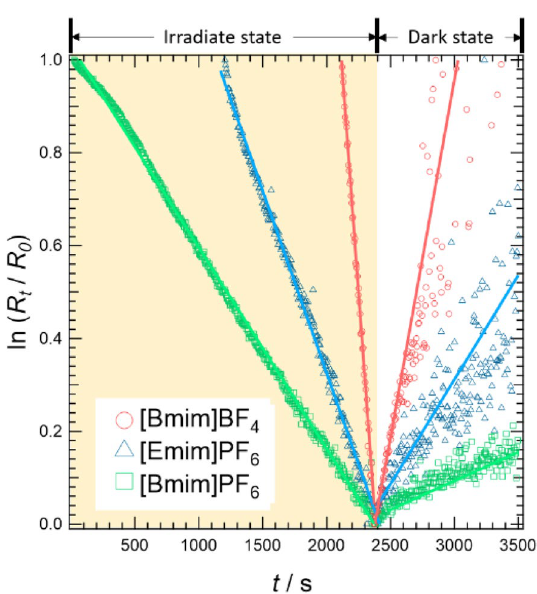
Figure 6. The time variation of the reflection spectrum intensity ln( R t / R 0 ) at λ = 575 nm is shown. The bottom axis indicates the time t from the start of light irradiation and measurements. Symbols and solid lines indicate raw data and fitting lines, respectively. The “irradiated state” is the period during which the sample was continuously irradiated with white light, and the “dark state” is the period after irradiation was turned